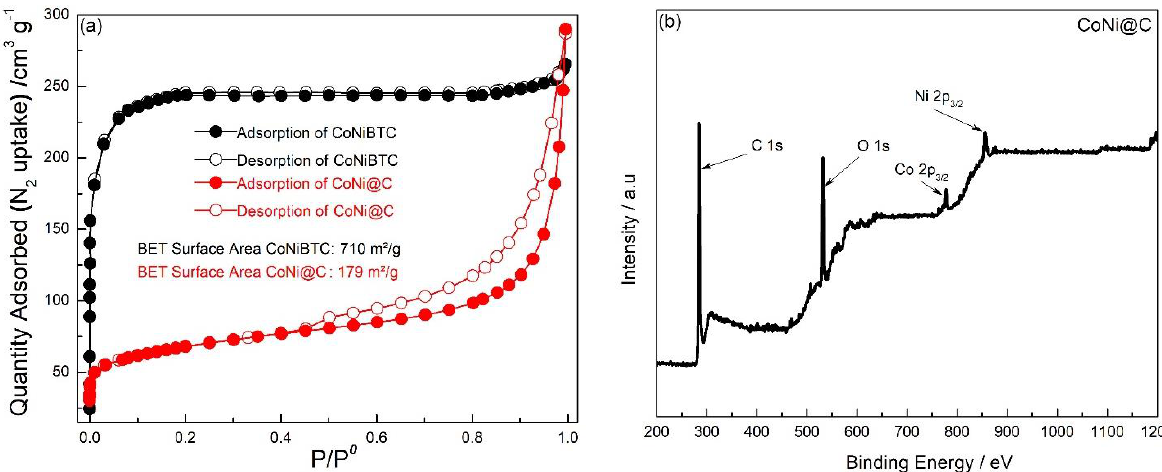
Figure 2. ( a ) The N 2 adsorption isotherm of CoNiBTC and CoNi@C; ( b ) XPS spectrum of CoNi@C.